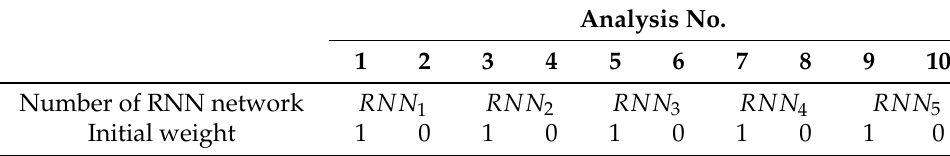
Table 2. Analyzed configurations of learning data and